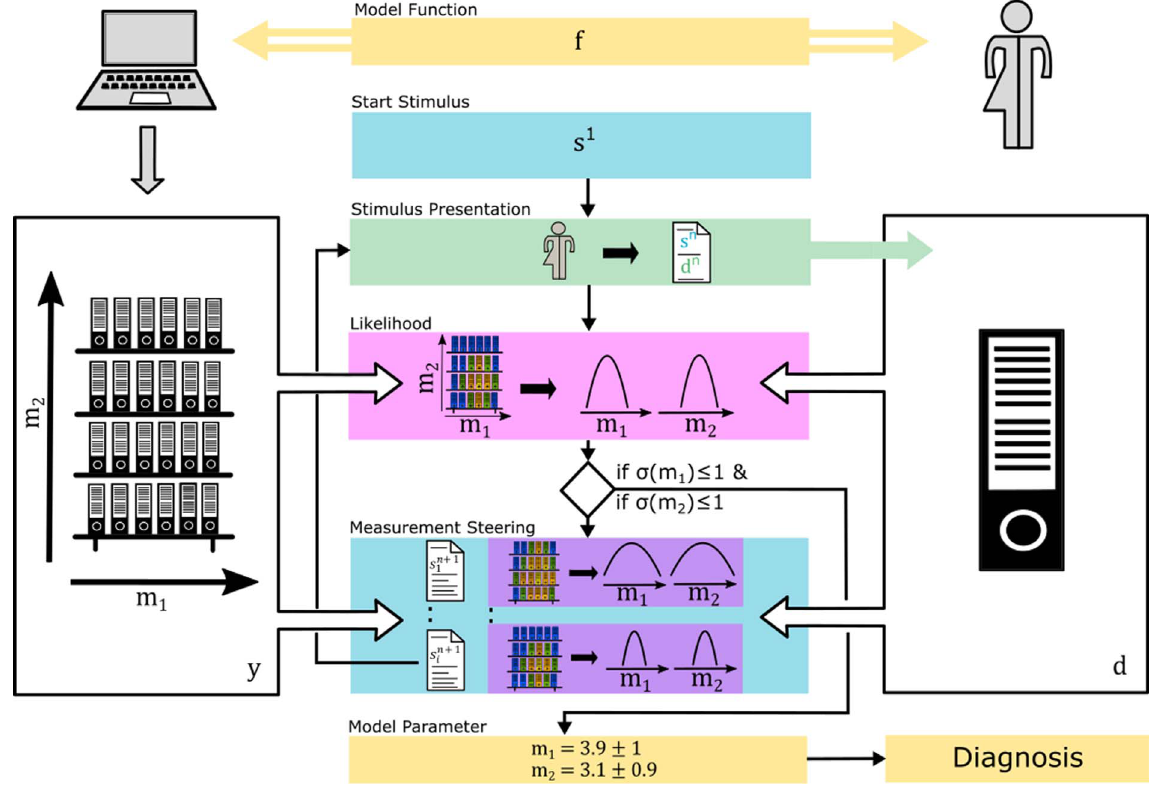
Figure 2. The general approach shown in Figure 1 extended with the model-based measurement steering. The calculation of the likelihood is carried out after every trial, to call up the prede fi ned termination criterion. As long as this is not ful fi lled, the next stimulus is calculated, simulating the next trial by adding all possible stimuli s i to data d . For every simulated stimulus, a likelihood function with the associated standard deviations is also determined in the simulation and the stimulus that leads to the smallest standard deviation of parameter estimates will be presented